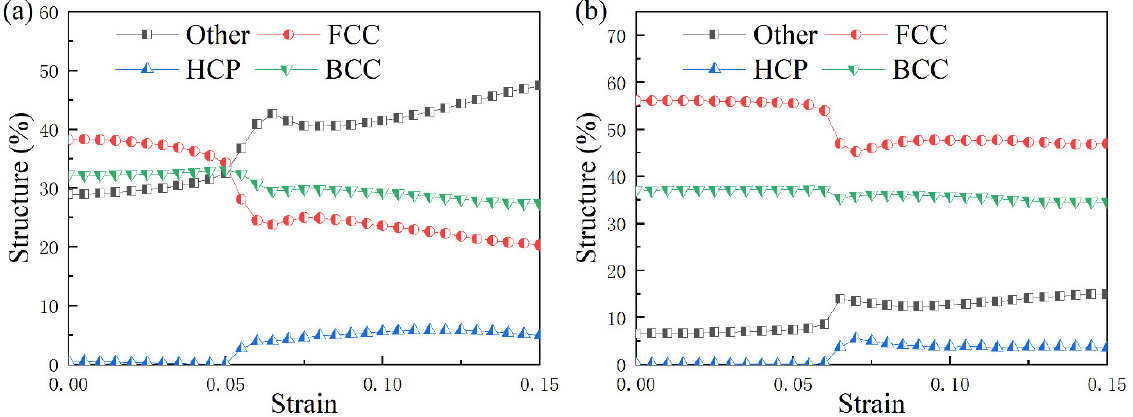
Figure 9. Atomic percentages of bcc, fcc, hcp and other disordered structures during uniaxial compression at 300 K: ( a ) h = 1.25 nm, ( b ) h = 5.6 nm.